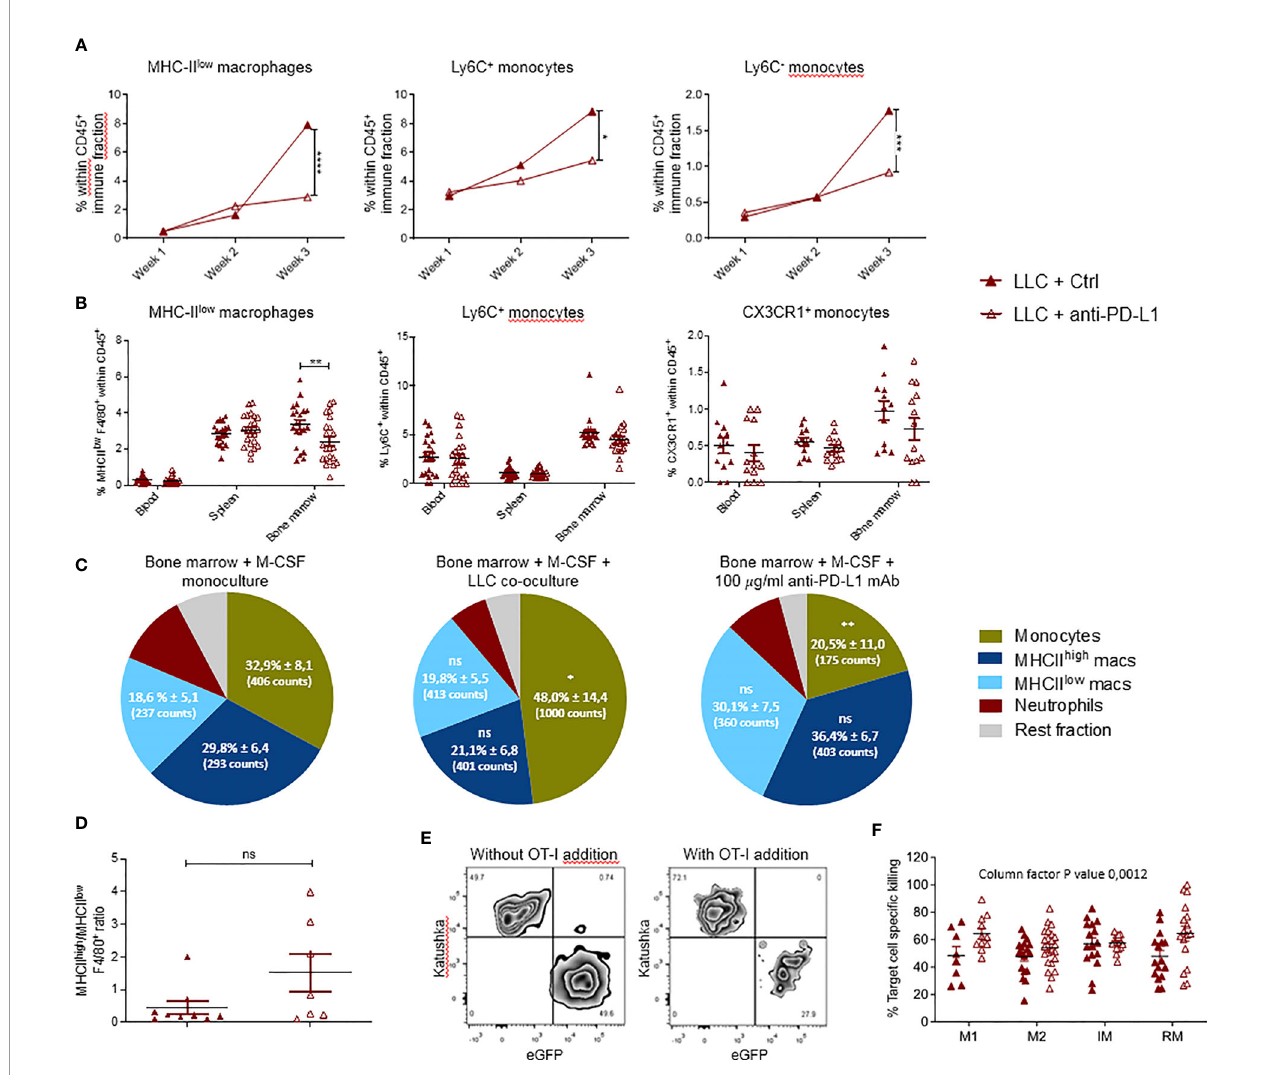
FIGURE 3 | Local and systemic impact of anti-PD-L1 therapy on myeloid cells. Mice were treated with Ctrl or anti-PD-L1 mAbs on days 4, 7, 10 and 13 after LLC- Fluc injection. On weeks 1, 2 and 3, mice of each group were sacri fi ced to isolate LLC-engrafted lungs. Blood, spleen and bone marrow were collected on week 3. (A) Graphs indicating changes in percentage of lung-in fi ltrated MHC-II low macrophages (left), Ly6C + monocytes (middle) and Ly6C - monocytes (right) within the CD45 + immune cell fraction assessed using fl ow cytometry (n=3, 1-3 mpc). (B) Percentages of MHC-II low macrophages (left), Ly6C + monocytes (middle) and CX3CR1 + monocytes (right) in peripheral organs as depicted on the x-axis (n=3, mpc=5-10). Two-way ANOVA with Sidak ’ s multiple comparisons test was performed to evaluate statistical signi fi cance. (C) Bone marrow-derived cells were cultivated with monocyte colony-stimulating factor (M-CSF) for 5 days. Next, cells were left untreated (left), co-cultured with LLC cells (middle) or 100μg/ml anti-PD-L1 mAb (right). One day later, alterations in myeloid subset composition were evaluated via fl ow cytometry. Percentages (± sd) from the total CD11b + population are shown. Percentages are accompanied by the average counts for the surface markers MHC-II low , MHC-II high and Ly6C to describe the mean fl uorescence intensity of MHC-II low macrophages, MHC-II high macrophages and monocytes resp. (n=5). (D) Graphical representation of the altered ratio of lung-residing MHC-II high over MHC-II low TAMs isolated from tumor-bearing mice treated with Ctrl or anti-PD-L1 mAbs. An unpaired t-test was performed to analyze statistical signi fi cance (n=3, 2-3 mpc). (E) Representative zebra plot of the LLC-speci fi c OT-I killing assay with gating of target LLC-eGFP/OVA and non-target LLC-Kat cells, with or without pre-stimulated CD8 + OT-I T cells. (F) Percentage target cell-speci fi c killing in the presence of MHC-II high TAM, MHC-II low TAM, Ly6C + in fl ammatory (IM) and CX3CR1 + residential (RM) monocytes sorted from lung tumor-bearing mice, treated with Ctrl or anti-PD-L1 mAbs (n=5, ≧ 3 biological replicates). For determination of statistical analysis in (A, C, F) , a two-way ANOVA with Tukey ’ s multiple comparisons test was performed. ns, non-signi fi cant; * for p < 0.05; ** for p < 0.01; *** for p < 0.001; and **** for p <